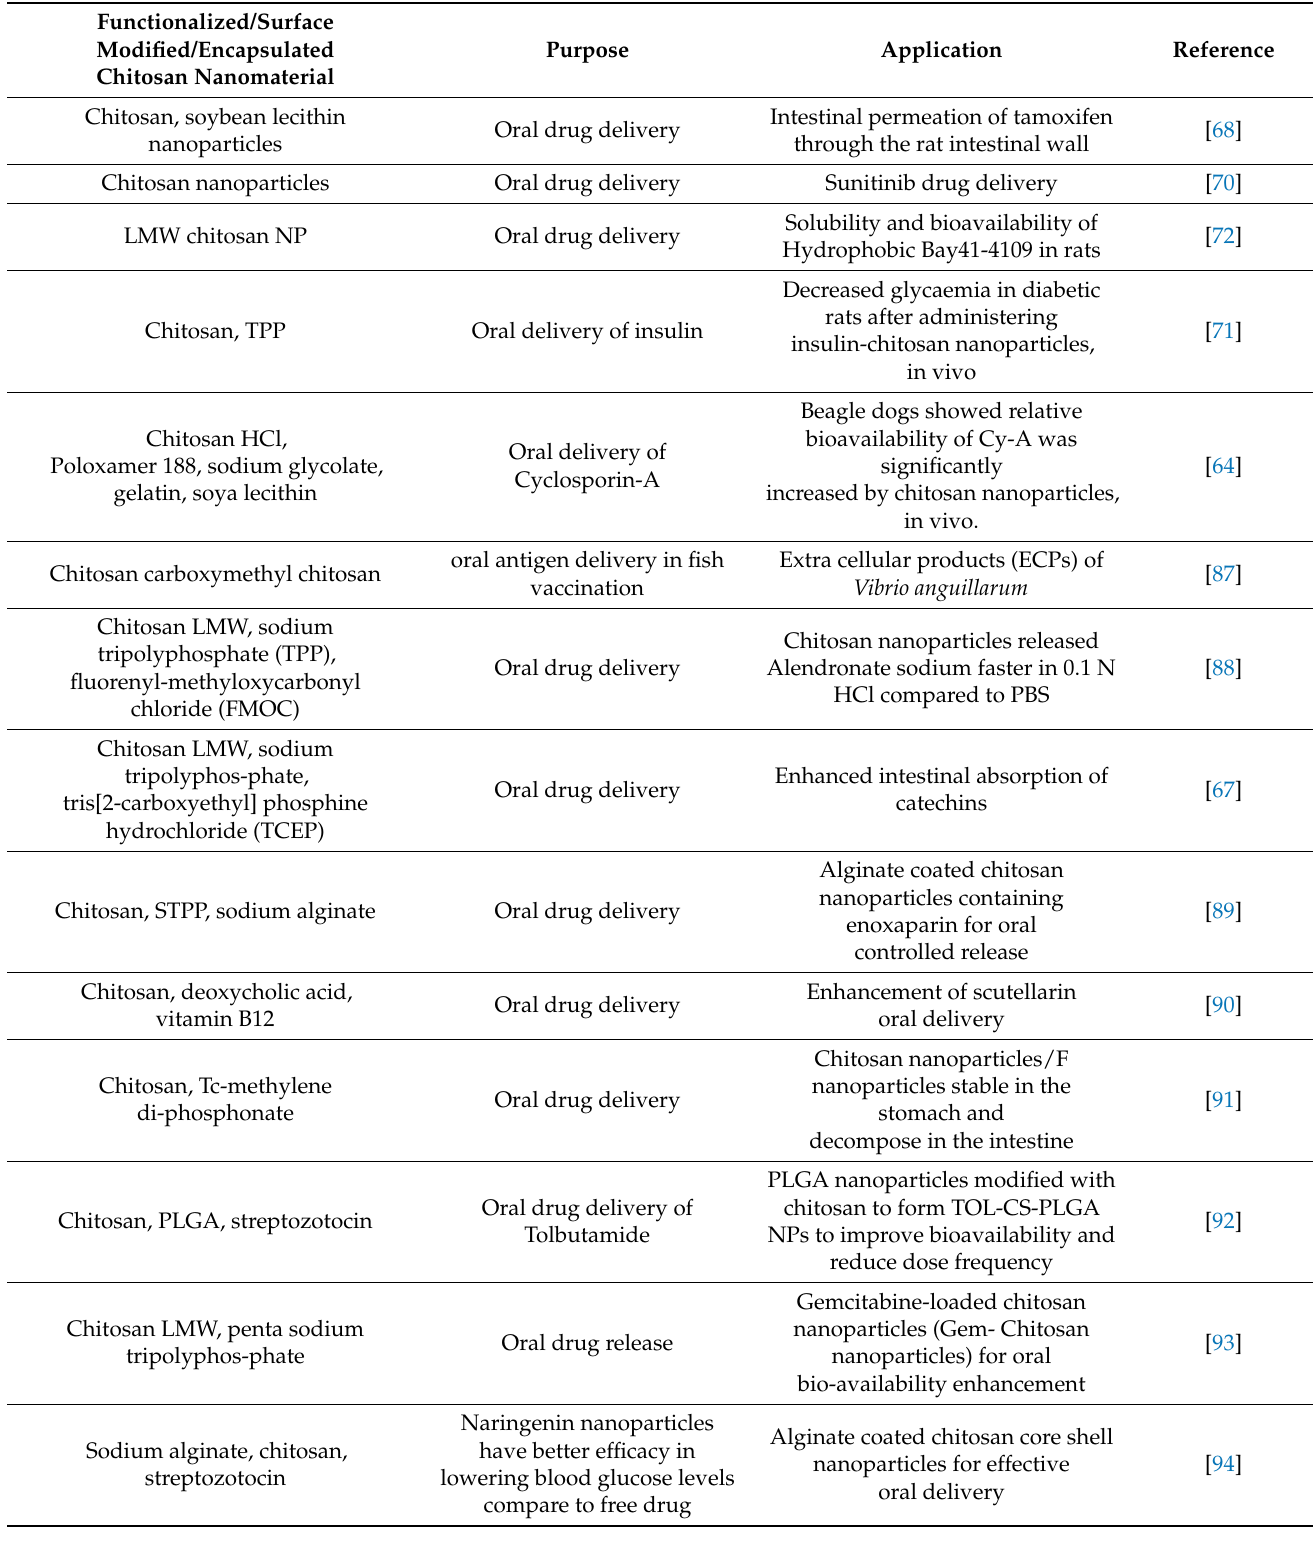
Table 1. Biomedical applications of modified chitosan